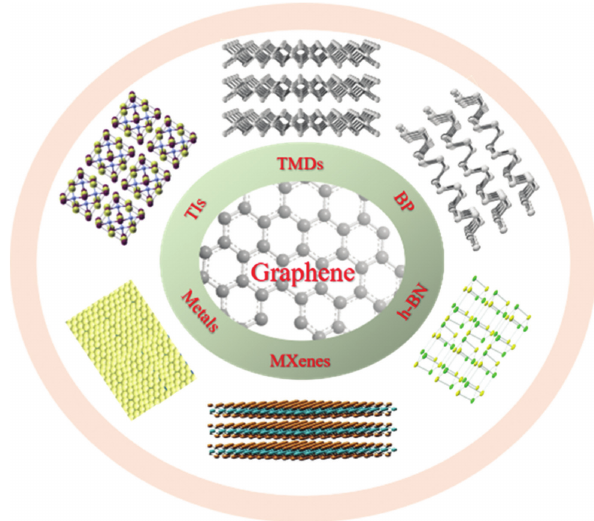
Figure 1: Schematic illustration of different kinds of typical ultrathin 2D materials, such as graphene, TMDs, BP, metals,